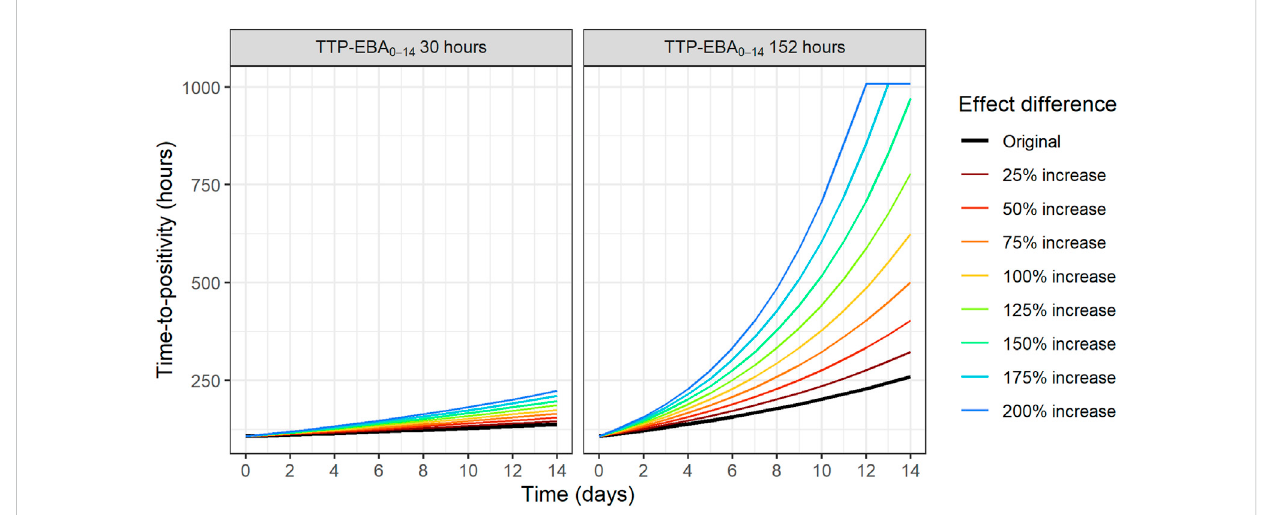
FIGURE 3 Visualization of typical pro fi les of time-to-positivity (TTP) over time for different effect difference values. Effect difference is expressed as a percentage increase in the TTP slope compared to the original value (red solid line). TTP values were right censored at 1,008 h (42